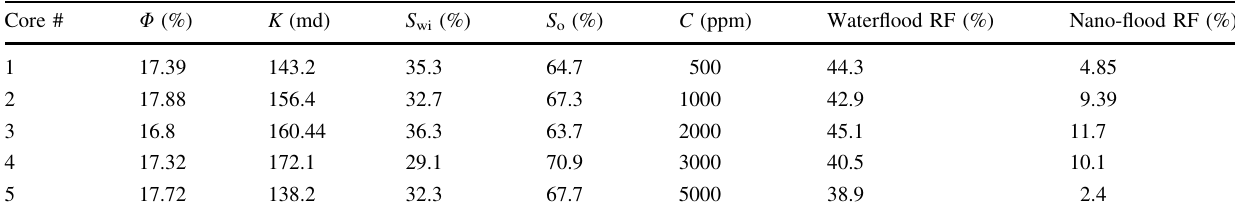
Table 7 Oil recovery of water and nano-flooding (cores 1 to